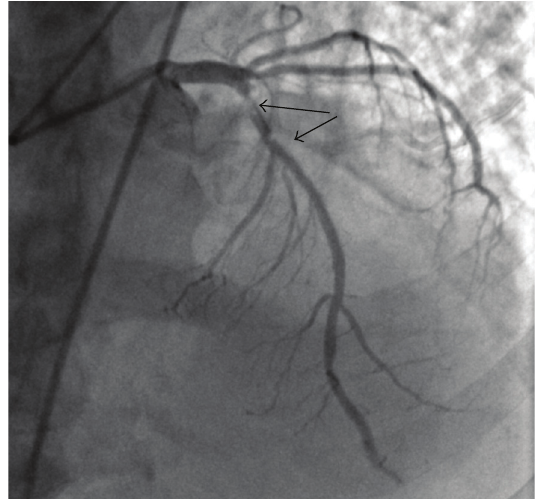
Figure 1: Arrows show thrombus compromising the flow in the left anterior descending artery.